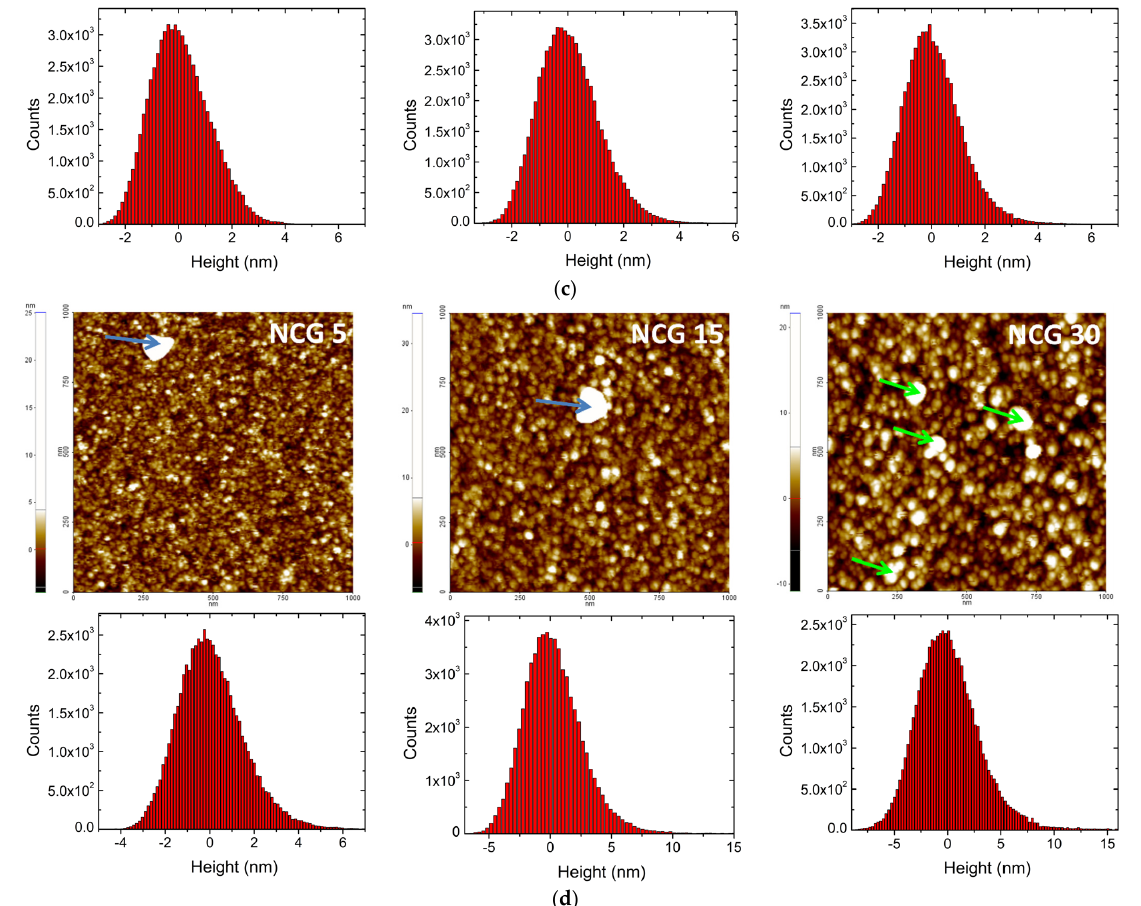
Figure 7. Two-dimensional AFM images of the LTO reference substrate and the NCG samples (top row of each subfigure), with the respective height histograms below each image, taken at an ( a , b ) 8 × 8 µ m 2 and ( c , d ) 1 × 1 µ m 2 scale.